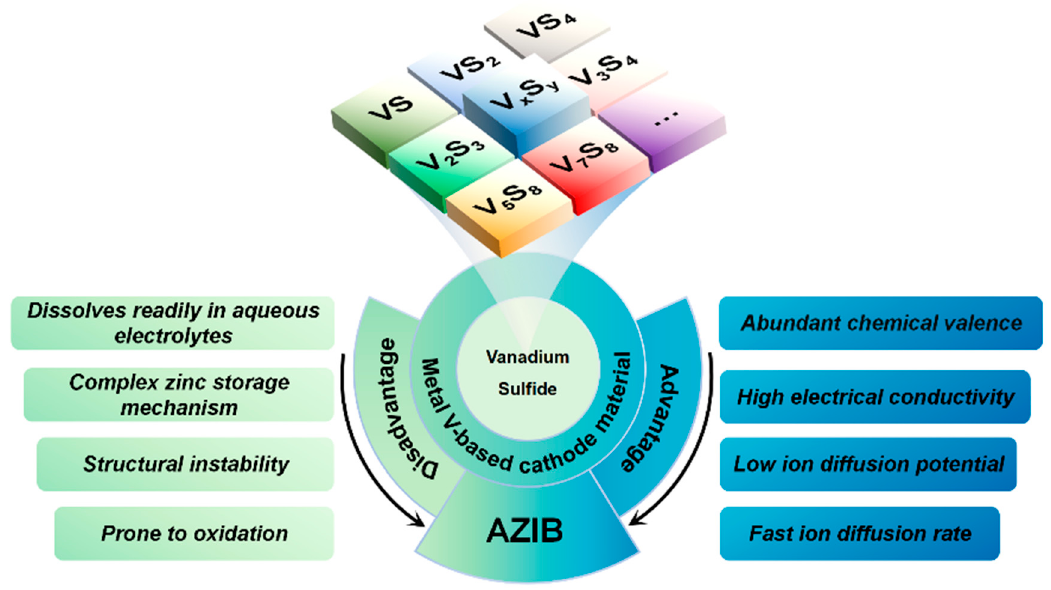
Figure 1. Types of vanadium-based sulfides and advantages and disadvantages of their application in aqueous zinc-ion batteries.